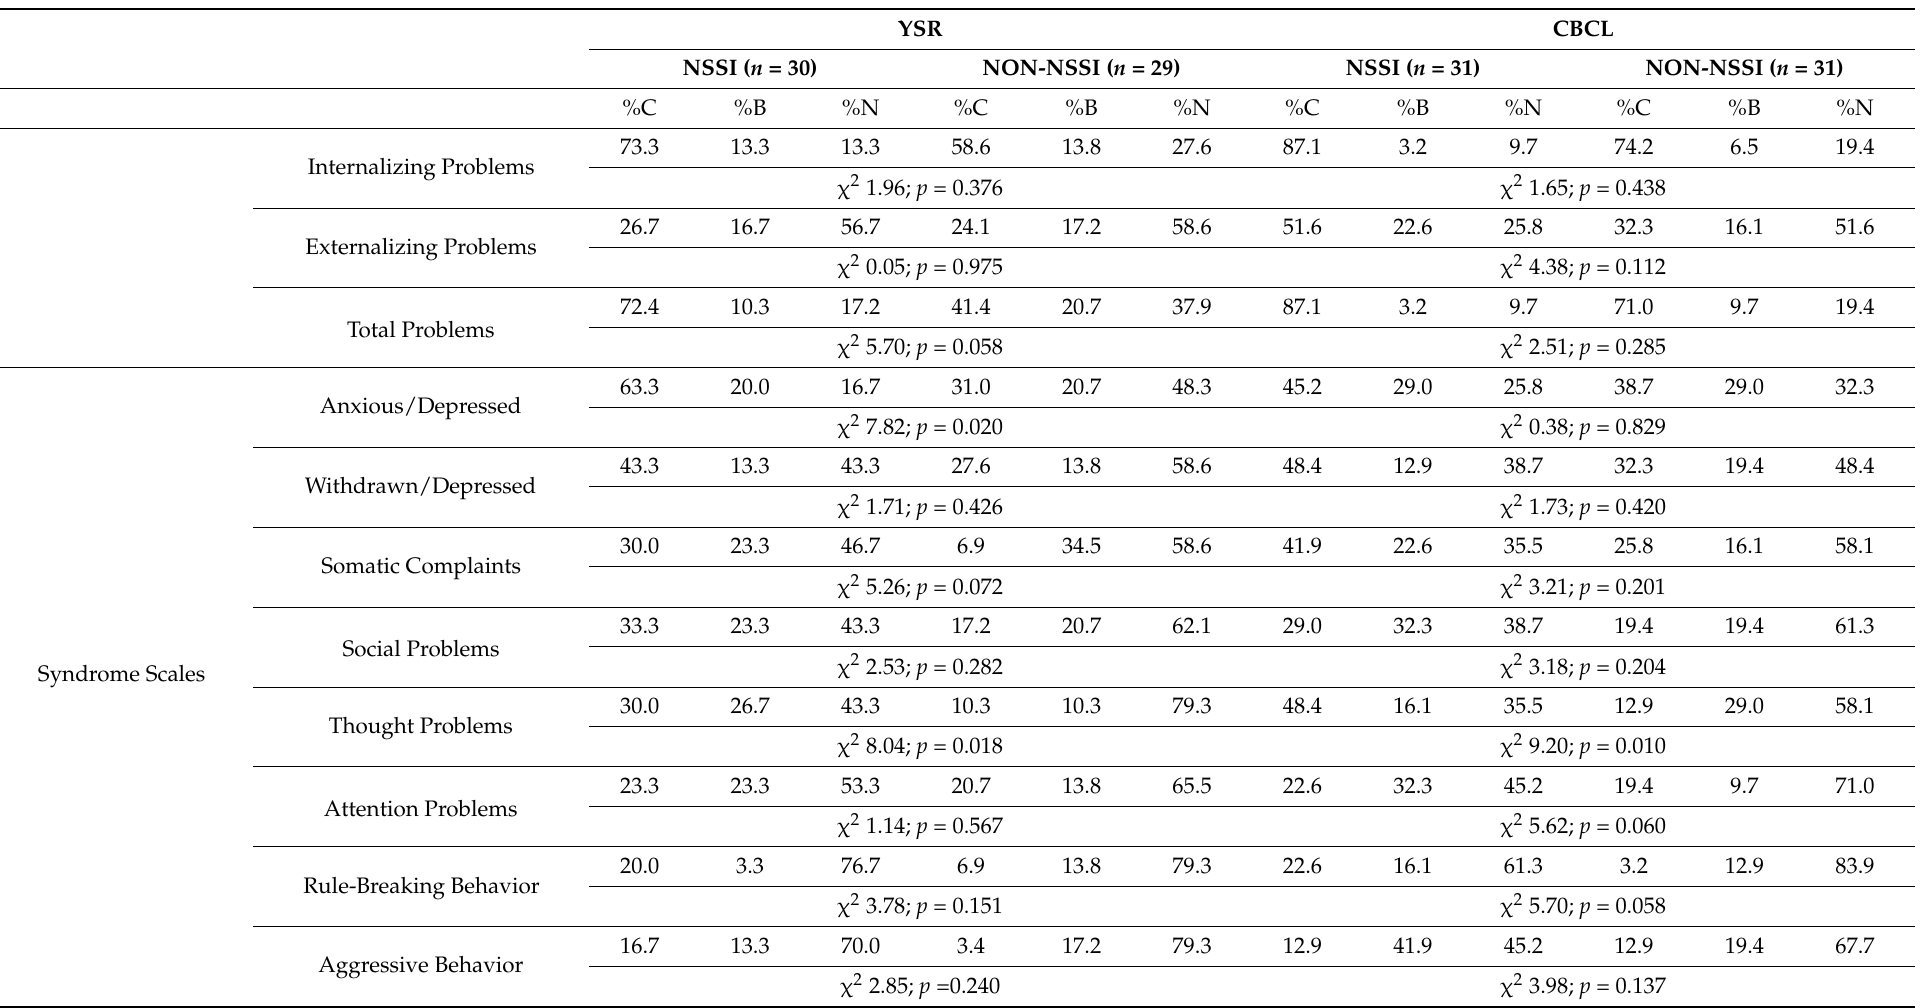
Table 2. Youth Self Report (YSR), Child Behavior Checklist (CBCL) χ 2 test with frequency of the Clinical, Borderline, and Normative results in the two